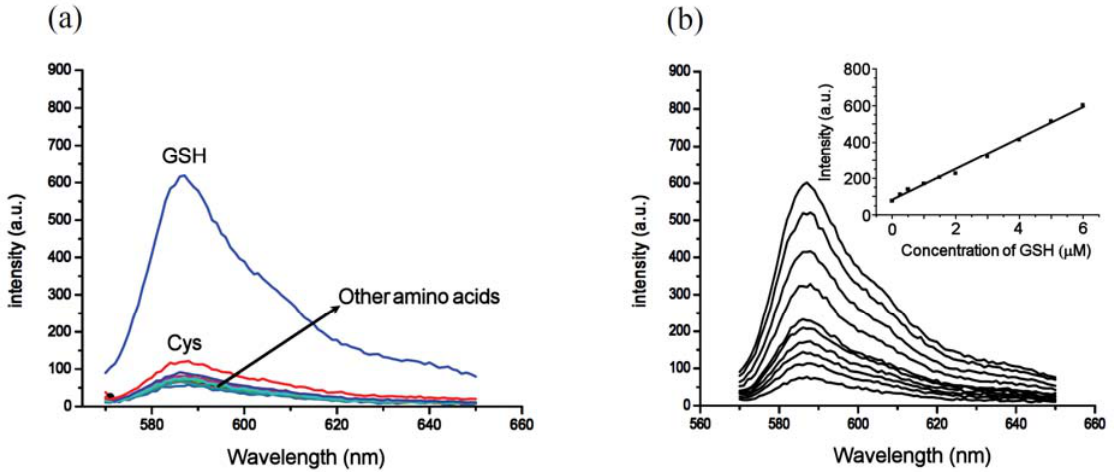
Figure 5. Surfactant mediated response of the 4- CTAB system toward 21 thiols and amino acids. ( a ) Fluorescence spectra ( λ = 565 nm) of 4 (2.5 μ M) upon addition of Cys, Hcy, ex GSH, leucine, proline, arginine, histidine, valine, methionine, threonine, glutamine, alanine, aspartic acid, norleucine, isoleucine, lysine, tryptophan, tyrosine, phenylalanine, cystine and homocystine (2 equiv) in 2.0 mM CTAB media at pH 7.4 (phosphate buffer, 50 mM). Spectra were taken immediately upon the addition of thiols and other amino acids; ( b ) Fluorescence spectra ( λ = 565 nm) of 4 (2.5 μ M) upon addition of increasing ex concentrations of GSH in 2.0 mM CTAB media at pH 7.4 (phosphate buffer, 50 mM). Spectra were taken immediately upon addition of CTAB. The inset shows a linear relationship between fluorescence intensity ( λ = 565 nm, λ = 587 nm) and GSH ex em concentration (0–6 µM) with a correlation coefficient of